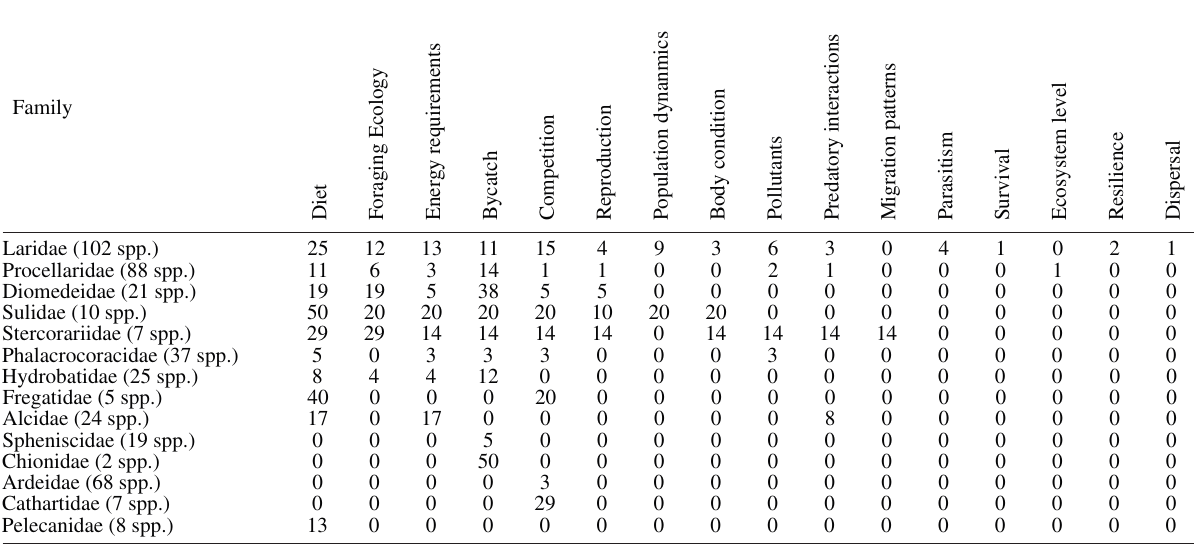
Table 1. – Percentage of species (regarding the total number of species of each taxonomic family) for which different ecological effects arising from seabird-discard interactions were evaluated by reviewed studies (e.g. the effect of fishery discards on the diet was evaluated in 25% of species belonging to the taxonomic family Laridae). The total number of species belonging to each family was consulted in https://www.itis. gov. The most common seabird families attending fishing vessels are shown in the upper part and less common ones in the lower part.